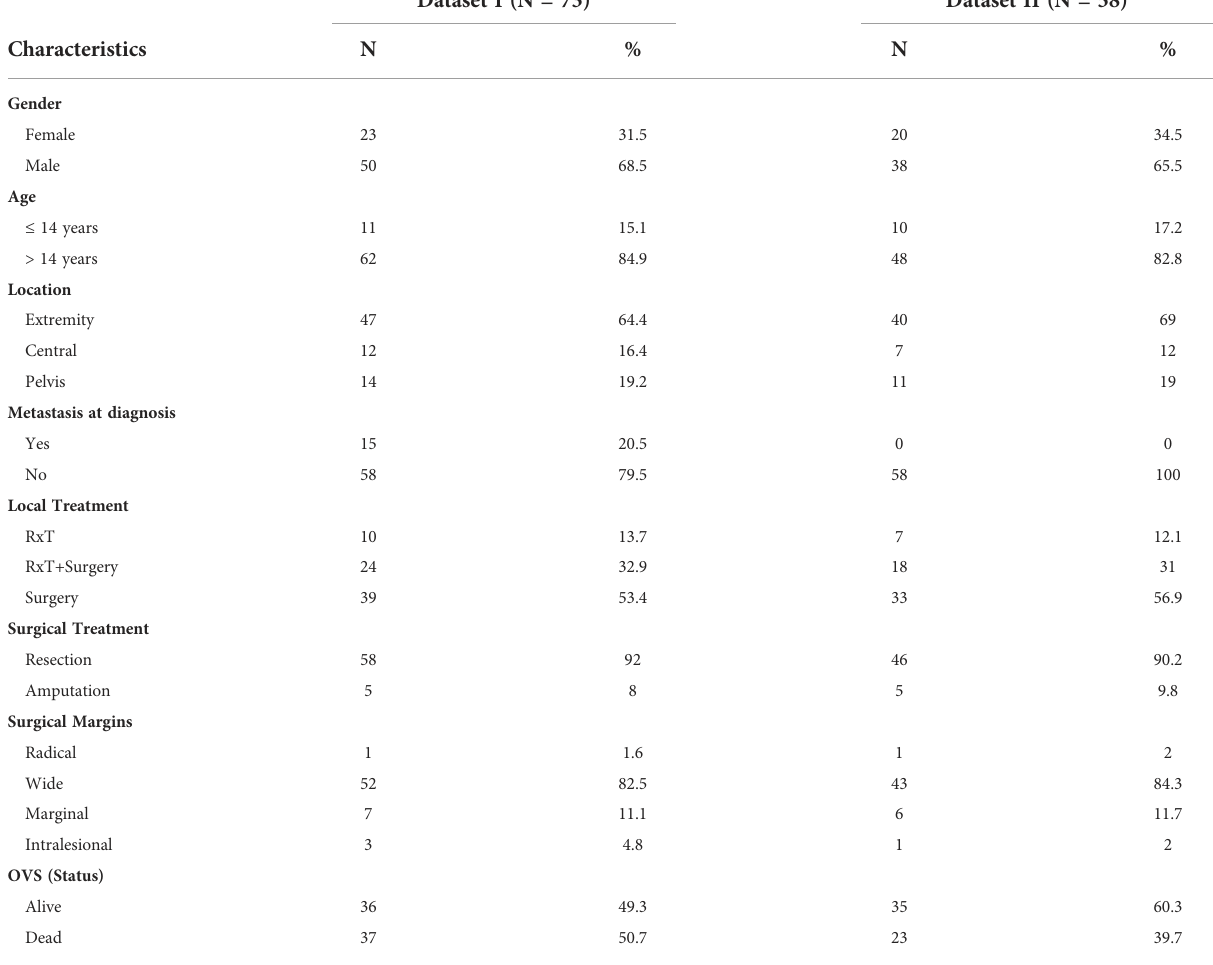
TABLE 1 Clinical-pathological features of EWS